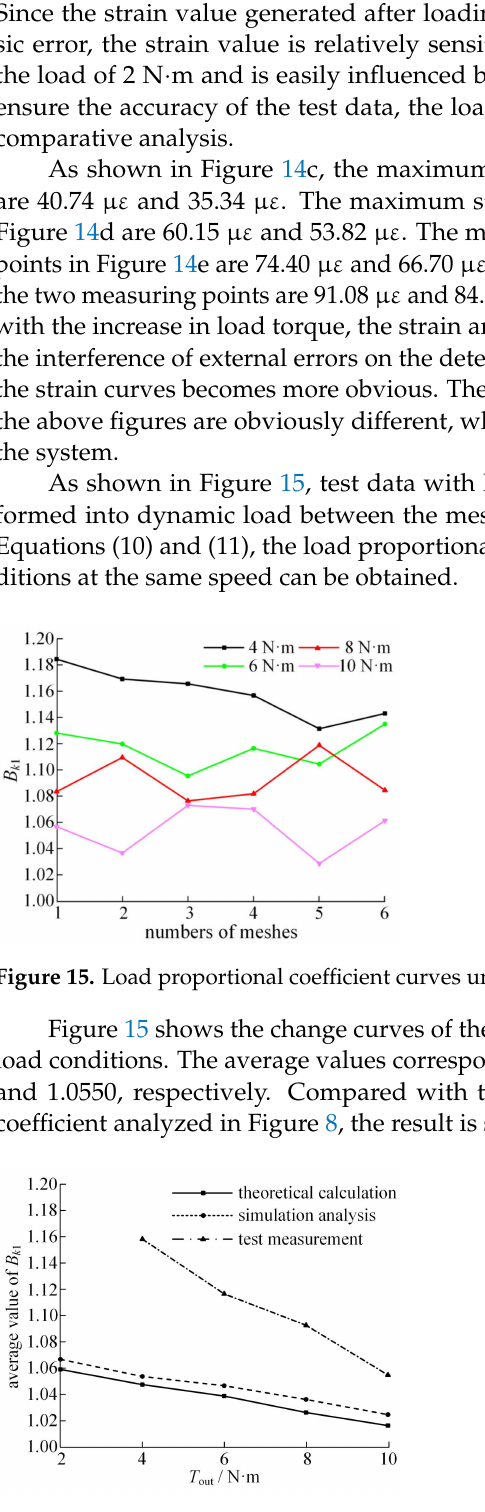
Figure 16. Variation curves of the average value of B k1 under different